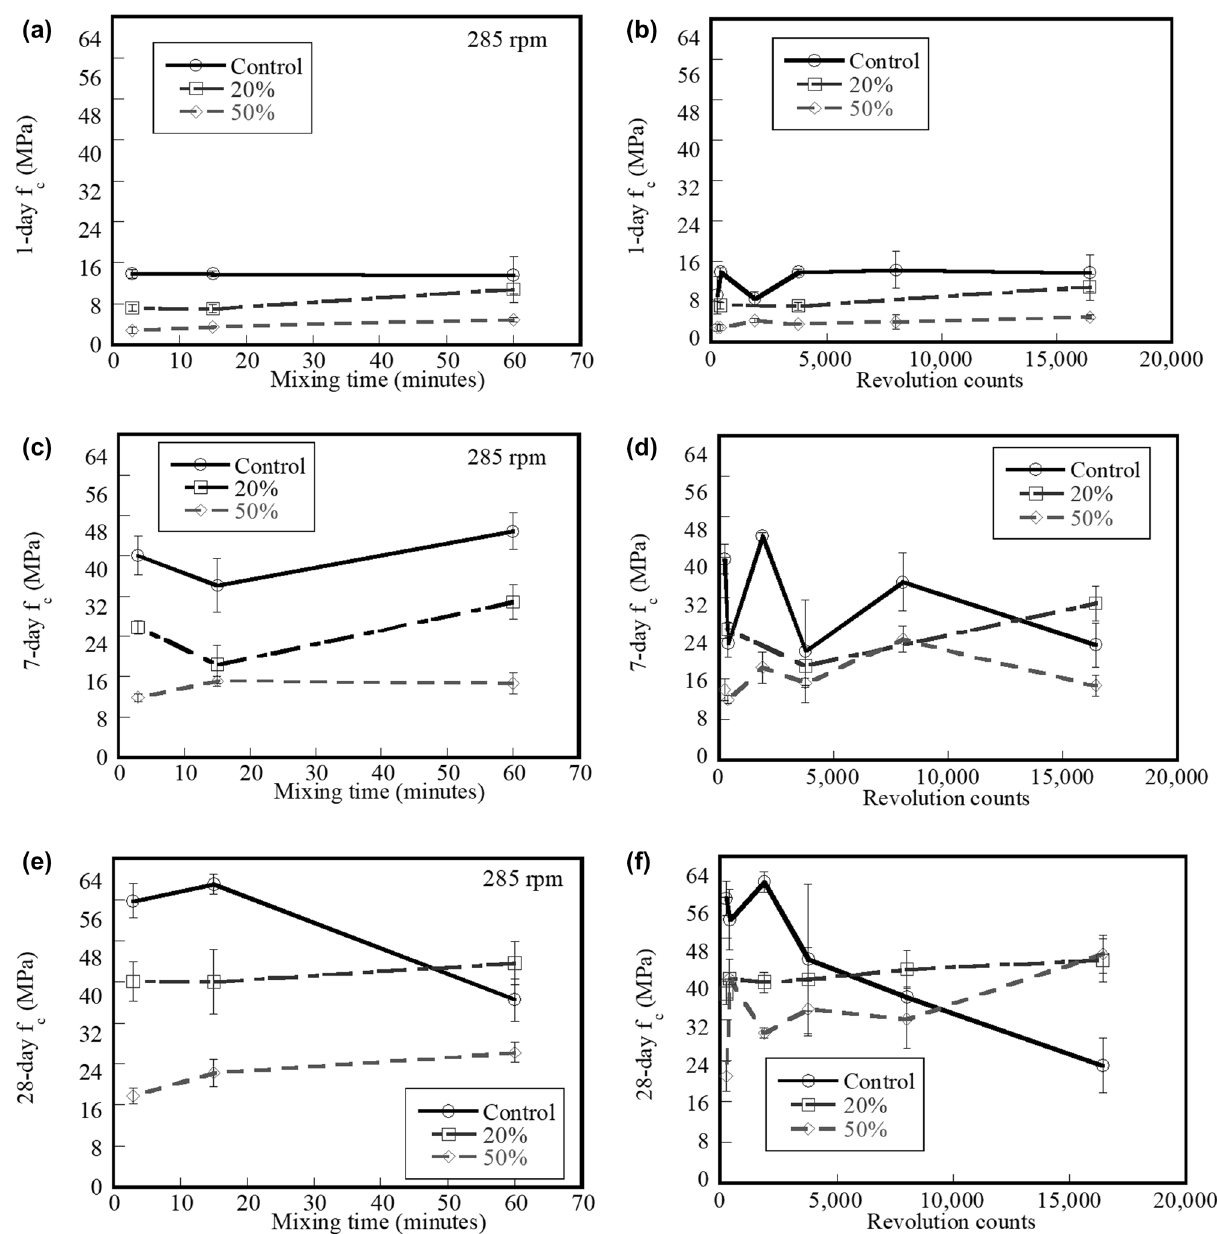
Figure 7. Effect of ( a ) mixing time and ( b ) mixer revolution counts on 1-day f c ; ( c ) mixing time and ( d ) mixer revolution counts on 7-day f c ; ( e ) mixing time and ( f ) mixer revolution counts on 28-day f c of control system and systems containing 20% and 50% fly